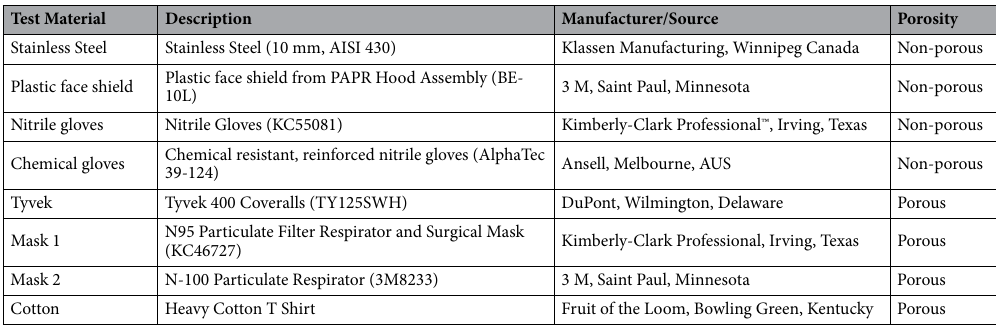
Table 1. Comprehensive descriptions of materials used for assessment of SARS-CoV-2 environmental